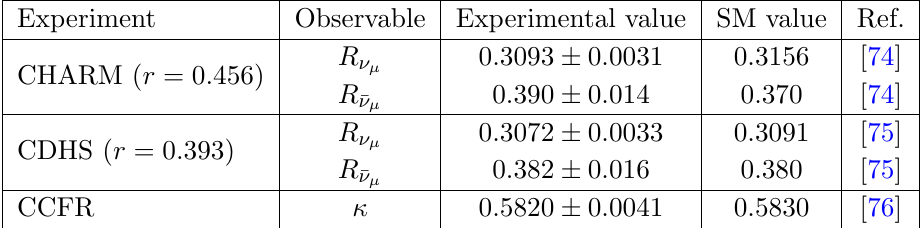
Table 3 . The results of muon-neutrino scattering experiments most relevant for constraining dimension-6 operators in the SMEFT. The SM values of R (cid:23) and (cid:20) include subleading correc- (cid:22) tions [77], whereas those of R (cid:22) (cid:23) are the tree-level values, which should be su(cid:14)cient taking into (cid:22) account the larger experimental